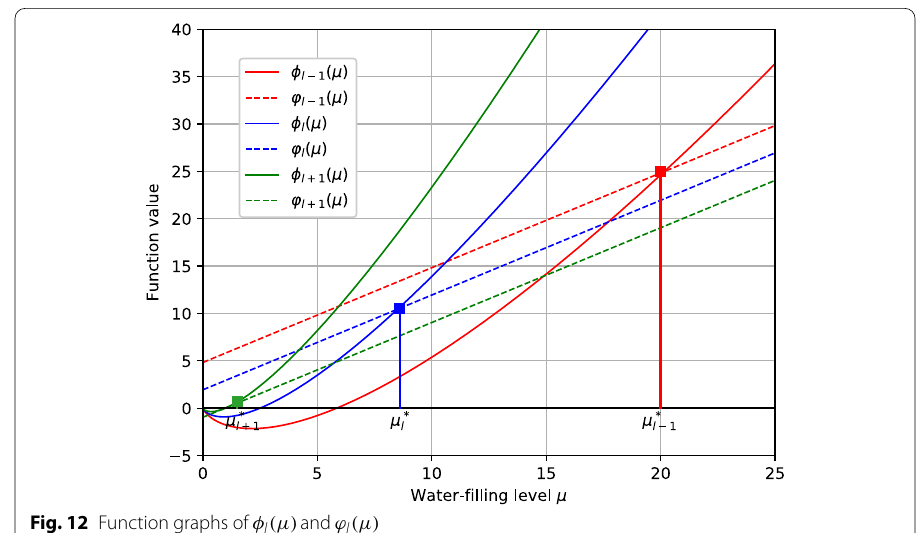
Fig. 12 Function graphs of φ l (µ) and ϕ l